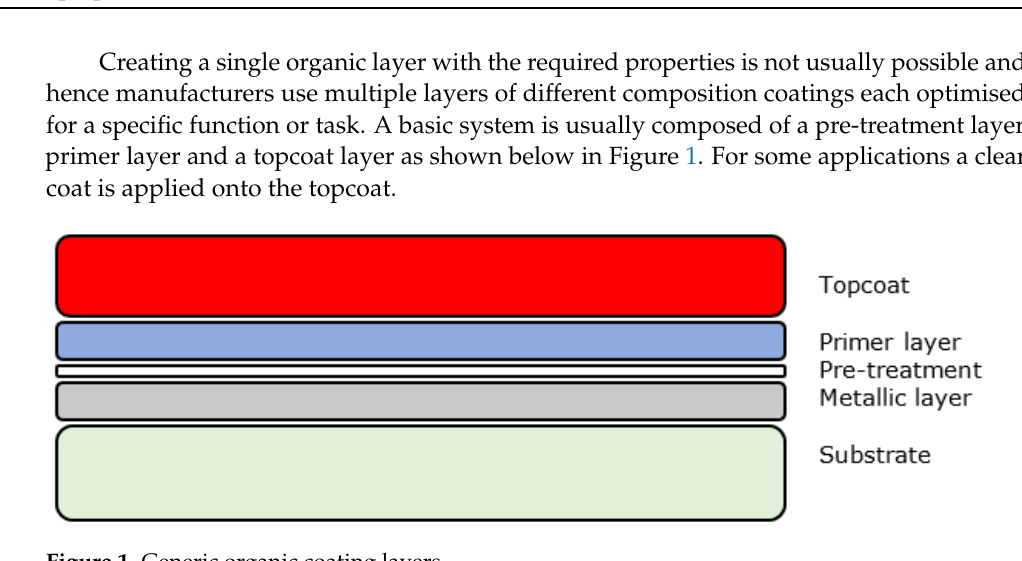
Figure 1. Generic organic coating layers.